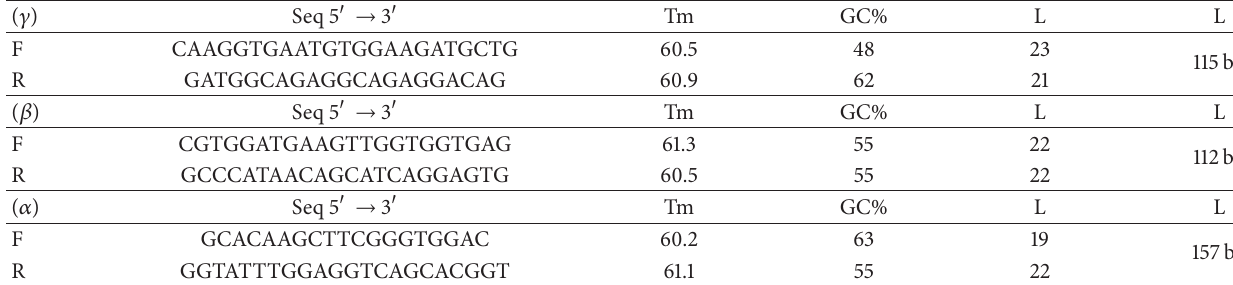
Table 1: The primers’